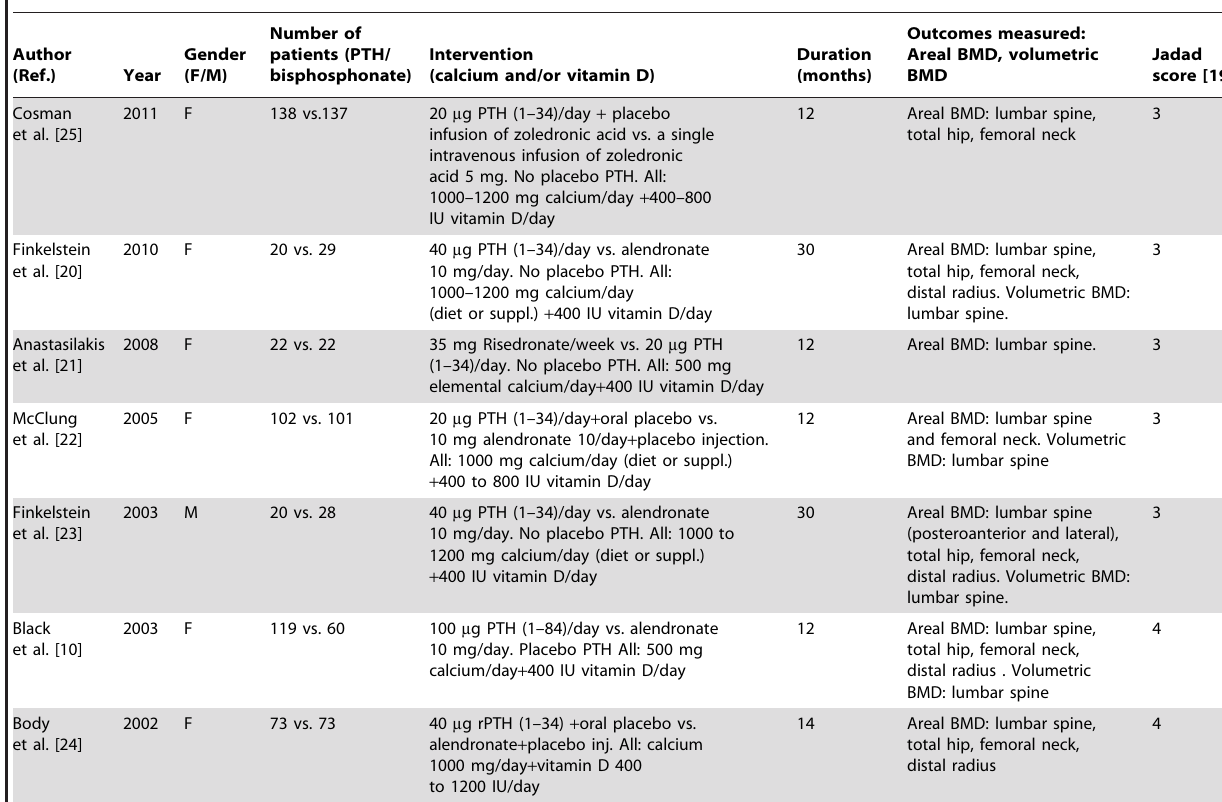
Figure 1. Flowchart of the meta-analysis. doi:10.1371/journal.pone.0026267.g001 Table 1. Basal characteristics of clinical trials enrolled in the